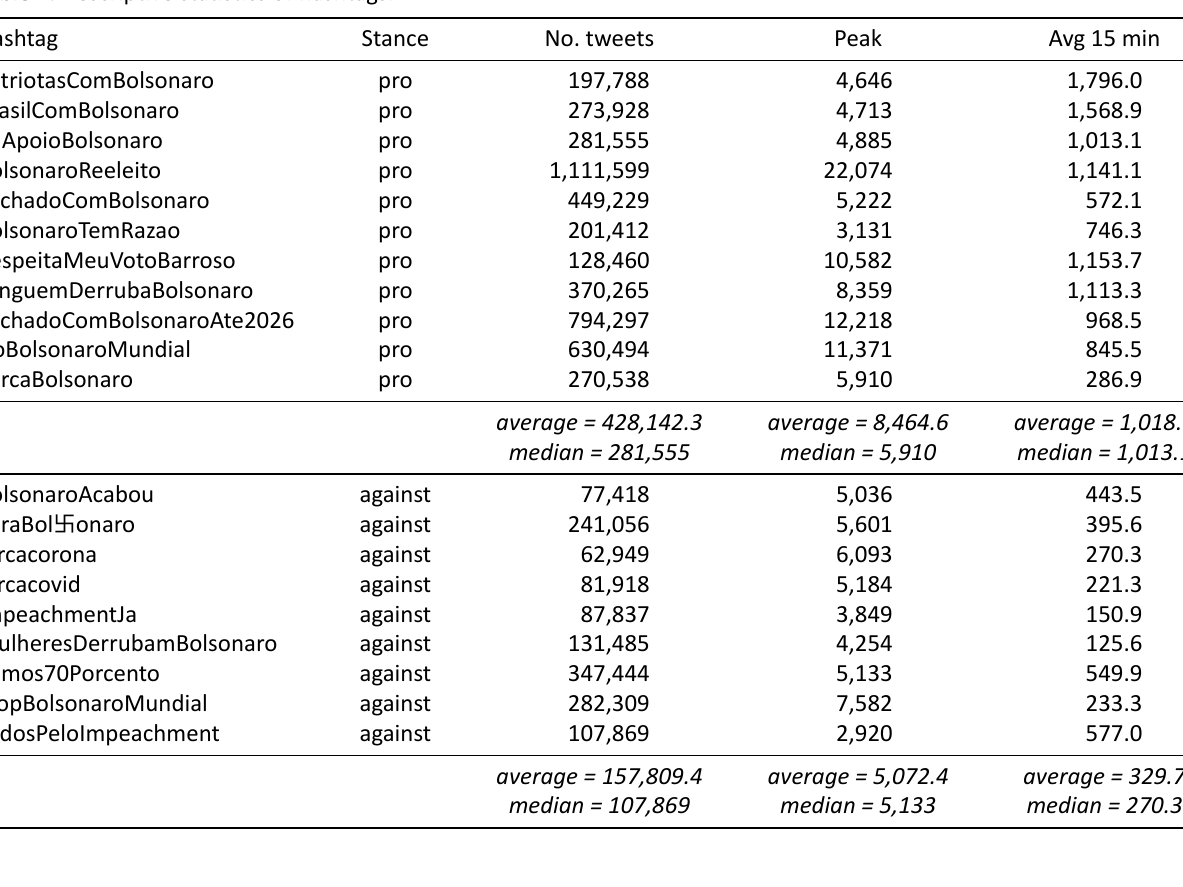
Table 1. Descriptive statistics of hashtags.